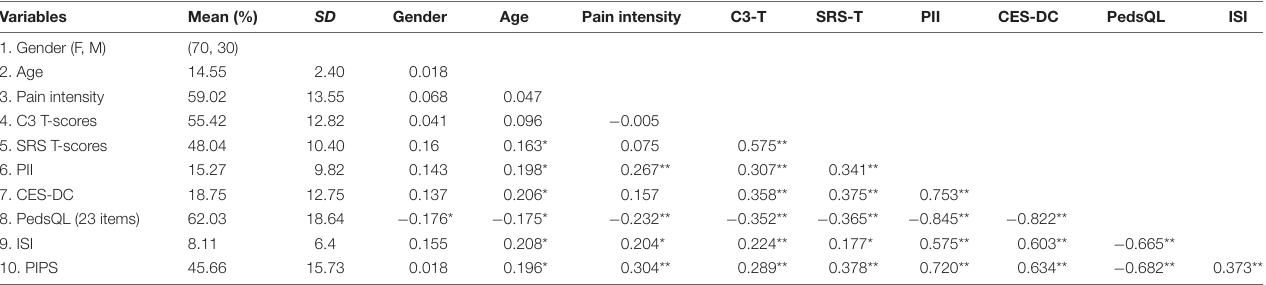
TABLE 1 | Descriptive statistics and correlations between control, predictor, and dependent variables and mediators ( n = 146 a ). Variables Mean (%) SD Gender Age Pain intensity C3-T SRS-T PII CES-DC PedsQL ISI